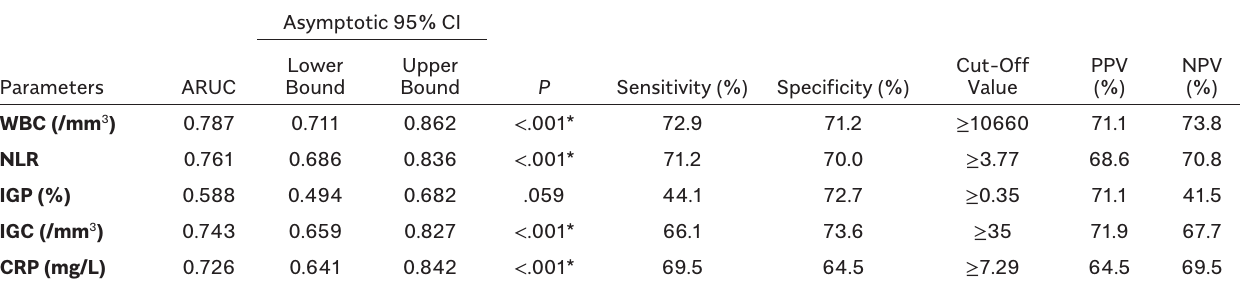
Table 4. ROC Analysis of WBC, NLR, IGP, IGC, and CRP for Group P